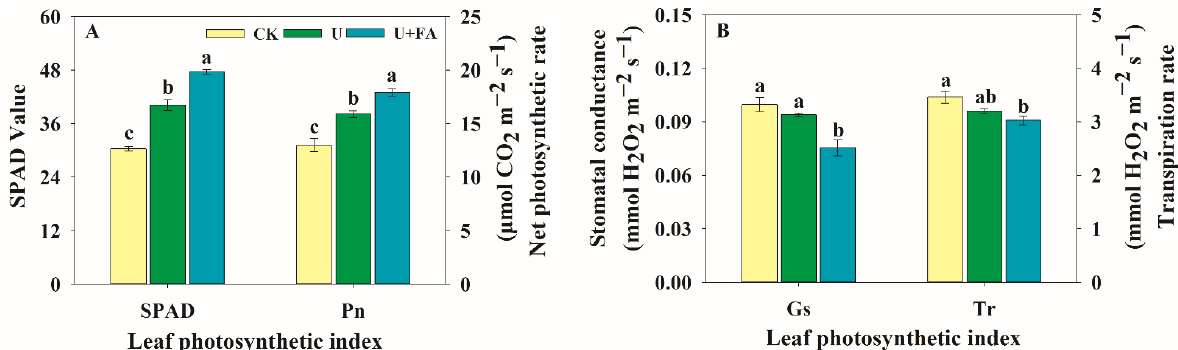
Figure 2. Effects of different fertilization treatments on SPAD value ( A ), net photosynthetic rate (Pn, ( A )), stomatal conductance (Gs, ( B )), and transpiration rate (Tr, ( B )) in maize leave at the jointing stage, in 2018. The treatments include: no nitrogen fertilizer (CK); application of urea (U); combined application of urea and fulvic acid solution (U+FA). The values are means of four replicates, and the error bars are standard errors. Different letters indicate significant differences between treatments for a same parameter according to SNK’s test at p <